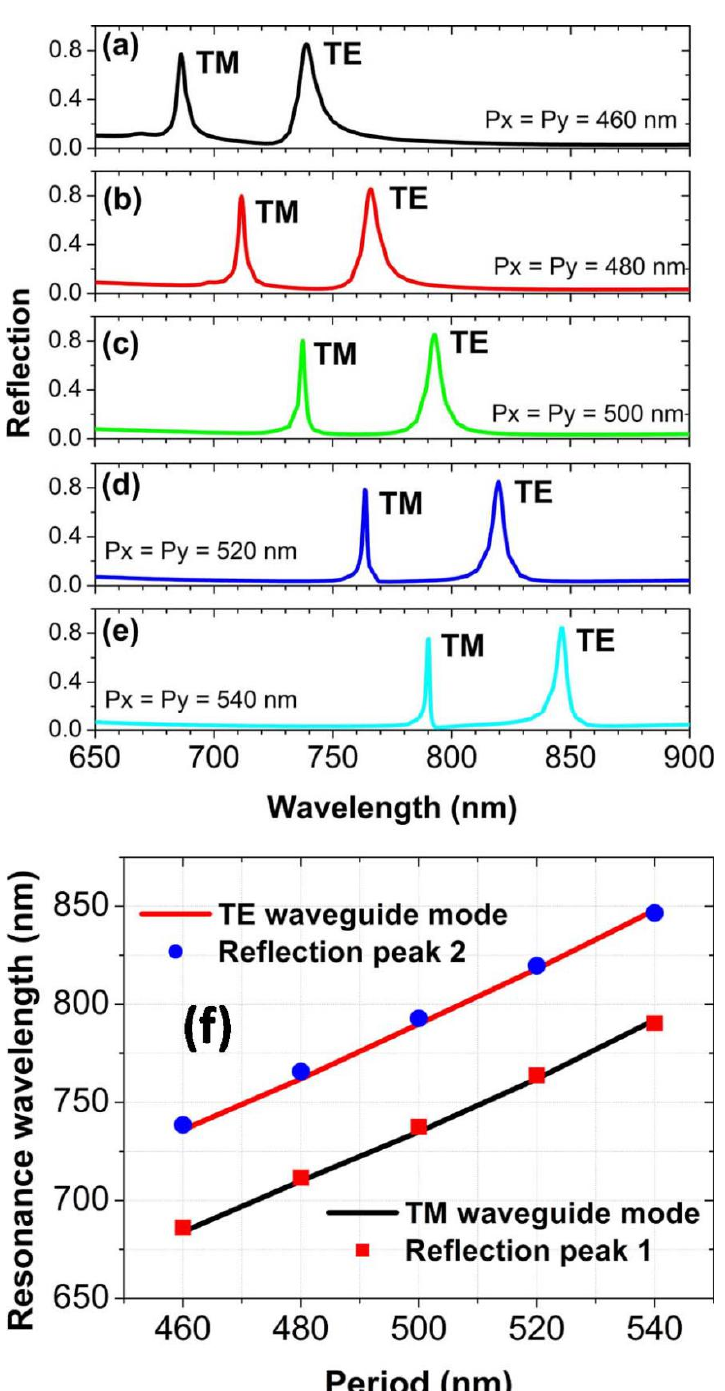
Figure 4. ( a – e ) The reflection spectra at normal incidence for different array periods of Au spheres. ( f ) Compare the positions of reflection peaks with the resonance wavelengths of waveguide modes.